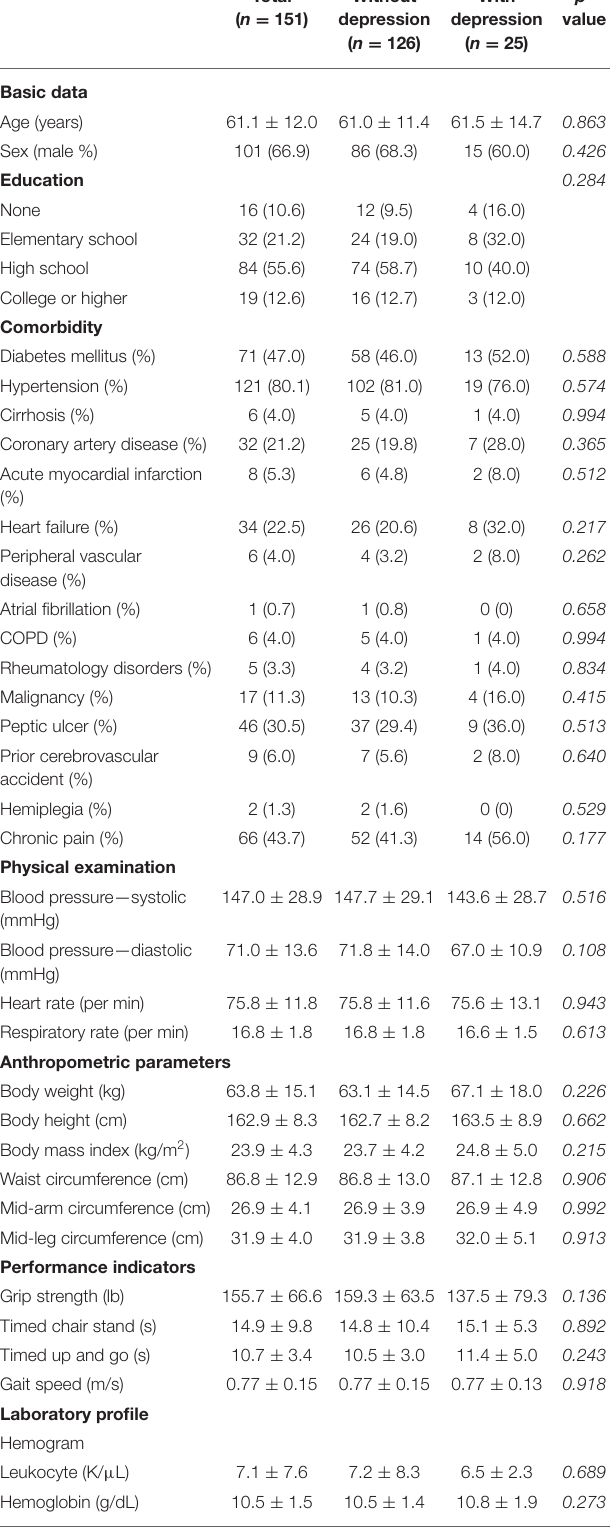
p - With Total Without depression ( n = 151) depression ( n = 25) ( n = 126)